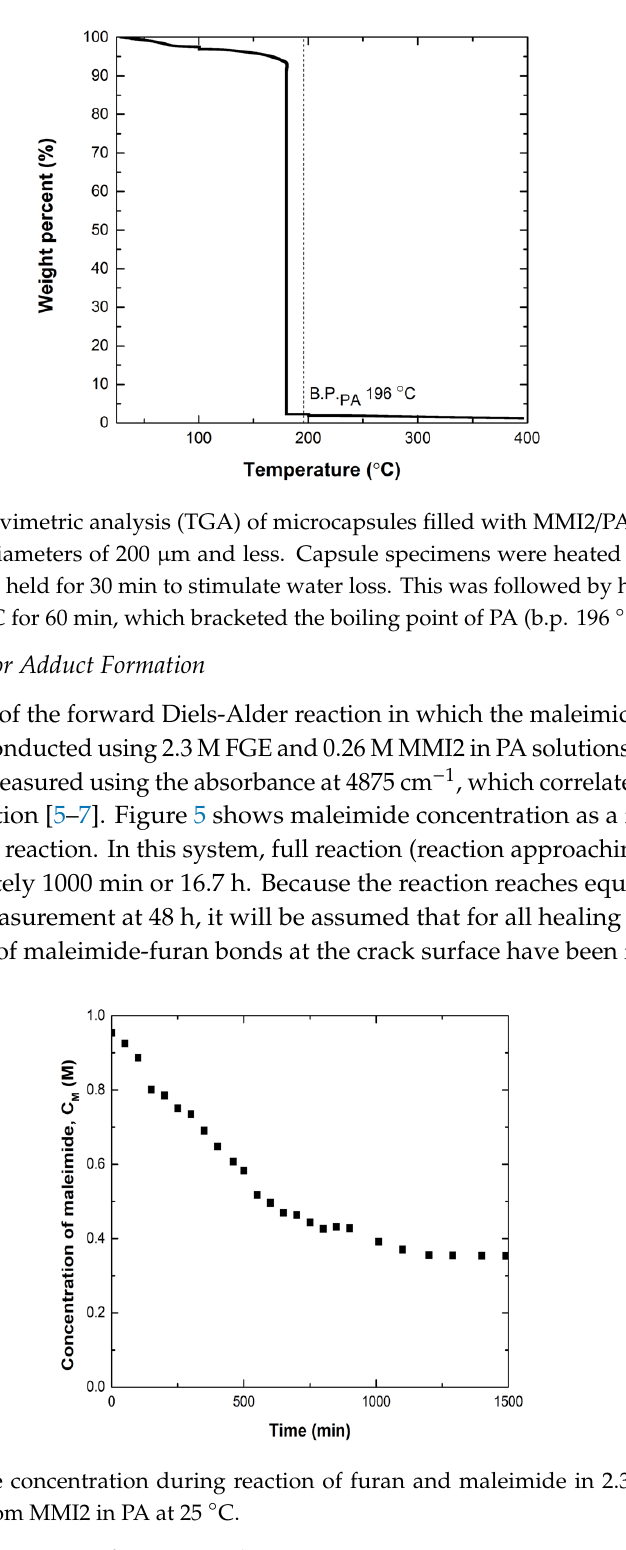
Figure 5. Maleimide concentration during reaction of furan and maleimide in 2.3 M FGE 0.26 M maleimide groups from MMI2 in PA at 25 °C.